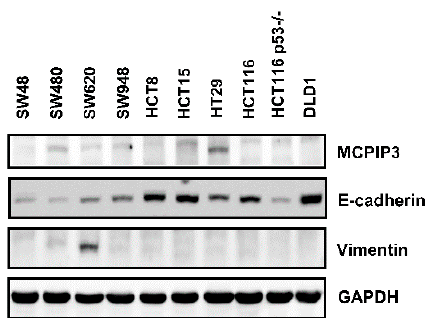
Figure 4. Protein expression levels of MCPIP3 in the ten human colorectal cancer cell lines. SW48, SW480, SW620, SW948, HCT8, HCT15, HT29, HCT116 wild-type, HCT116 p53 − / − , and DLD1 cells were cultured for 24 h, and then total proteins were collected to determine MCPIP3 protein expression by a Western blot analysis.